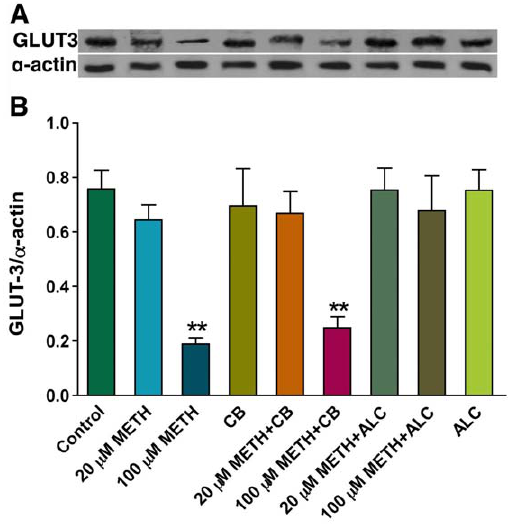
Figure 4. Western blot analysis for GLUT3 expression in METH treated human neurons. A-B: Effects of METH on GLUT3 (45 kDa) protein levels in human neurons. Bar graph shows the results, which are expressed as ratio of GLUT3 to that of a -actin bands, and presented as the mean values ( 6 SEM; n=5). (Statistically significant, **p , 0.01 compared with